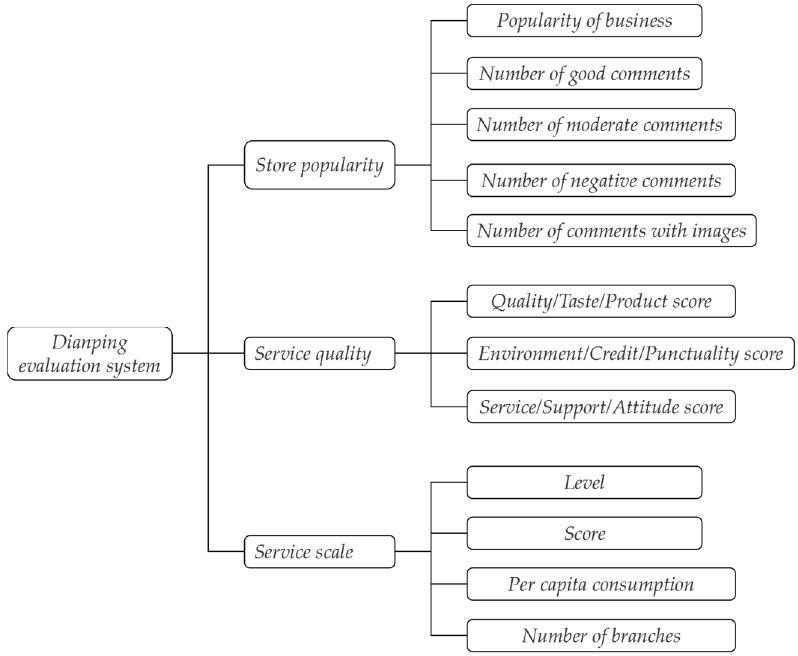
Figure 3. The “Dianping” evaluation system in measuring economic dynamism.